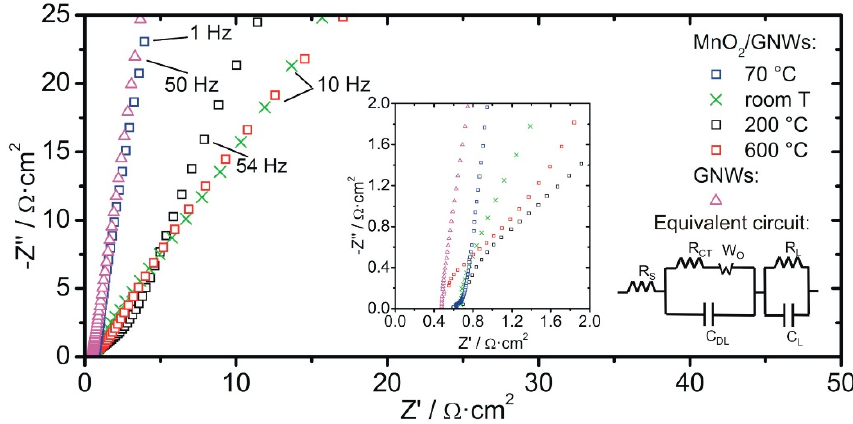
Figure 8. Nyquist plot of the samples: bare GNWs and MnO 2 /GNWs nanocomposite without annealing (room T) and annealed at 70 °C, 200 °C, and 600 °C. Inset shows real axis intercection and the modified Randles equivalent circuit used to fit the data of MnO 2 /GNWs.